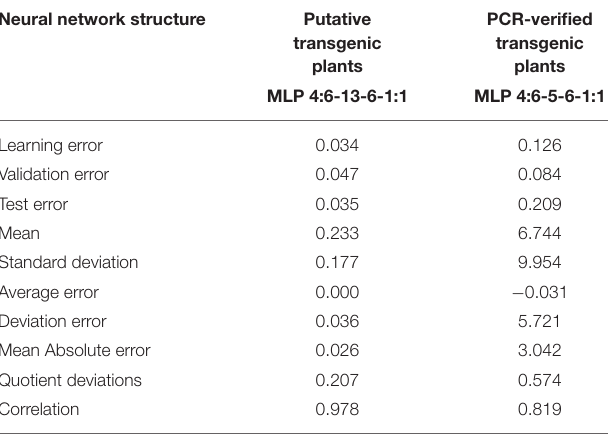
TABLE 2 | Basic information of the quality and structure of the neural models produced for putative and PCR-verified transgenic tobacco plants. Neural network structure Putative